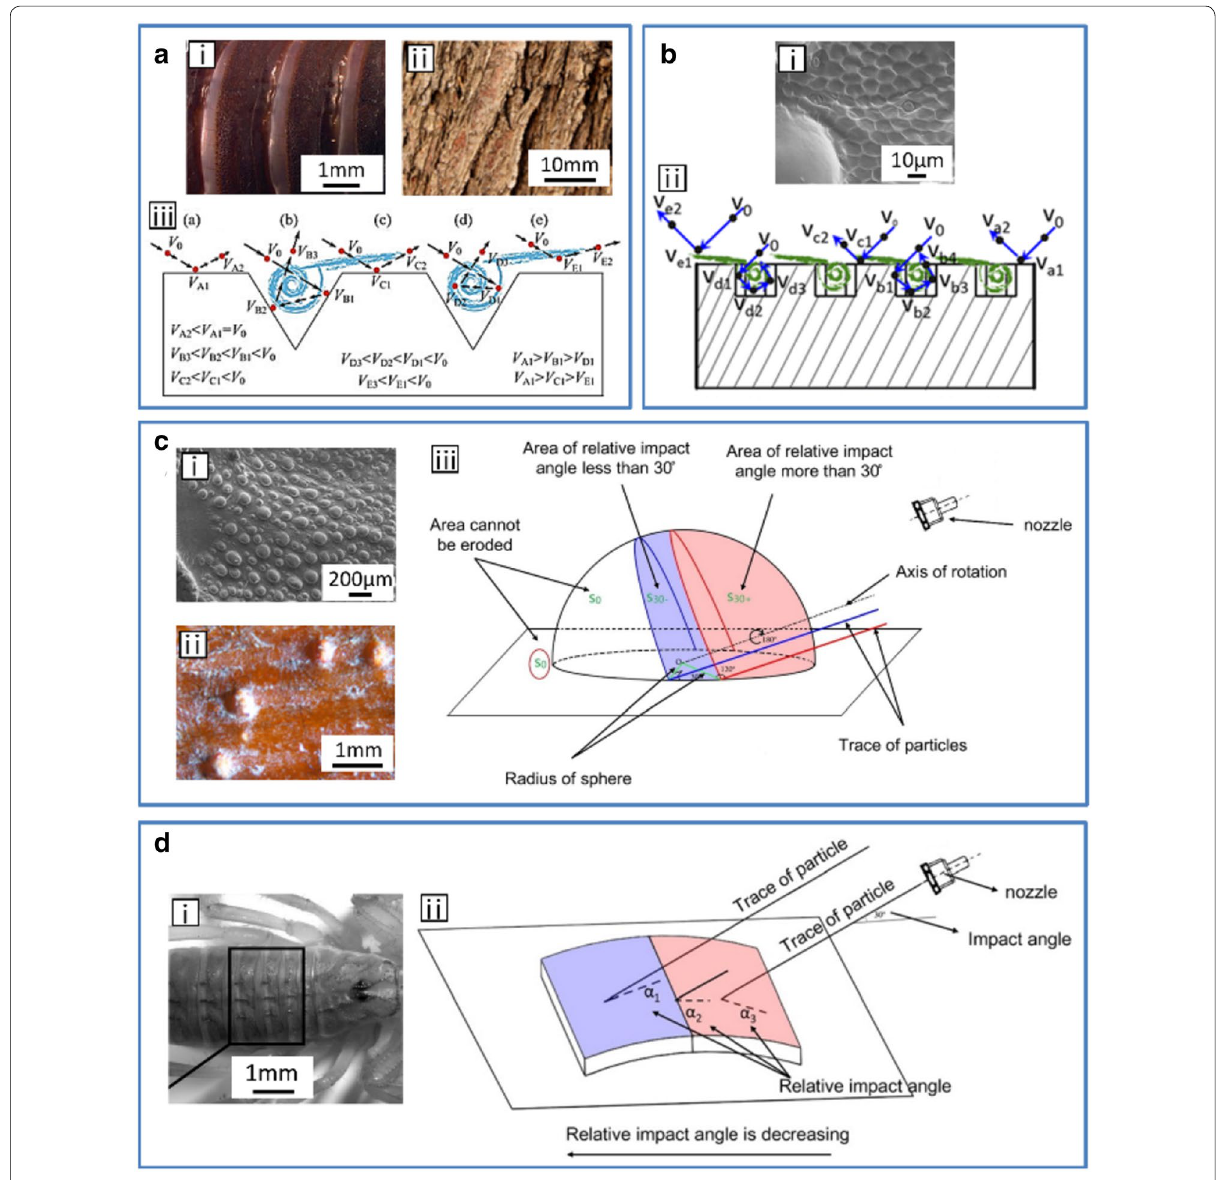
Figure 5 Special surface structures and their anti-solid particle erosion mechanisms: ( a ) (i) Grooves of the desert scorpion ( Androctonus australis ) [19], (ii) grooves of the tamarisk ( Tamarix chinensis ) [20], (iii) the anti-solid particle erosion mechanism of grooves ( Androctonus australis ) [20]; ( b ) (i) Pits of the desert scorpion ( Androctonus australis ) [19], (ii) the anti-solid particle erosion mechanism of pits [19]; ( c ) (i) Bumps of the desert scorpion [19], (ii) bumps of the tamarisk ( Tamarix chinensis ) [66], (iii) the anti-solid particle erosion mechanism of a bump [66]; ( d ) (i) Curve of the desert scorpion ( Androctonus australis ) [66], (ii) the anti-solid particle erosion mechanism of a curve